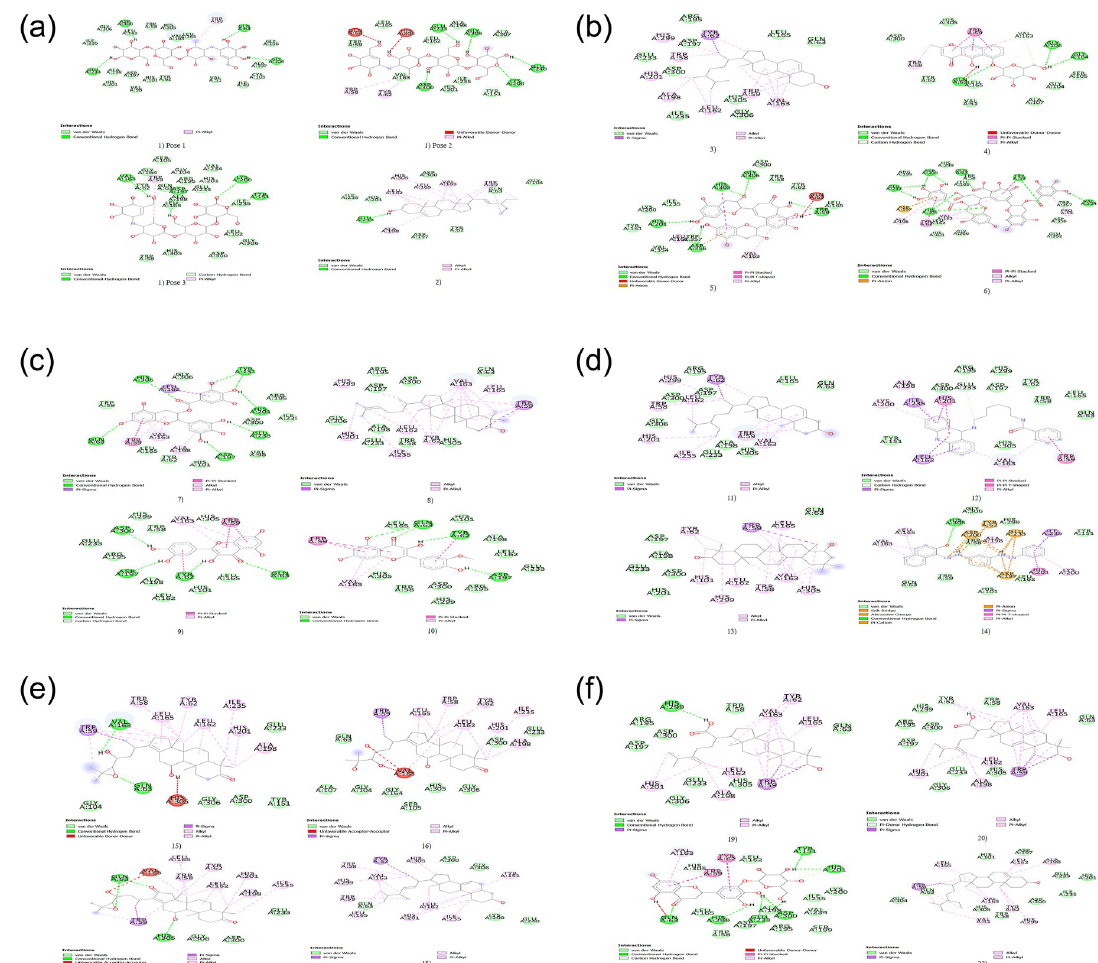
Fig 5. a. 2D diagram of top 3 predicted ligands from each herb with 1OSE. Hydrogen bonds (green circles with traced lines), van der Waals forces of attraction (light green circles), Pi-Alkyl interactions (pink circles with traced lines), Pi-Sigma interaction (purple circles with traced lines). 1) Acarbose (3 binding poses); 2). Stigmasterol. b. 3) Campesterol; 4) Cassiaside; 5) Theaflavin; 6) Thearubigin. c. 7) EGCG; 8) Cycloartenol; 9) Quercetin; 10) Isorhamnetin. d. 11) Beta-sitosterol; 12) N-[6-(acridin-9-ylamino) hexyl] benzamide; 13) Sophoradiol; 14) Sudan III. e. 15) Alisol B; 16) Alisol A. 17) Alisol C; 18) Stellasterol. f. 19) Eburicoic acid; 20) Dehydroeburicoic acid; 21) plantagoside; 22) Daucostero_qt.